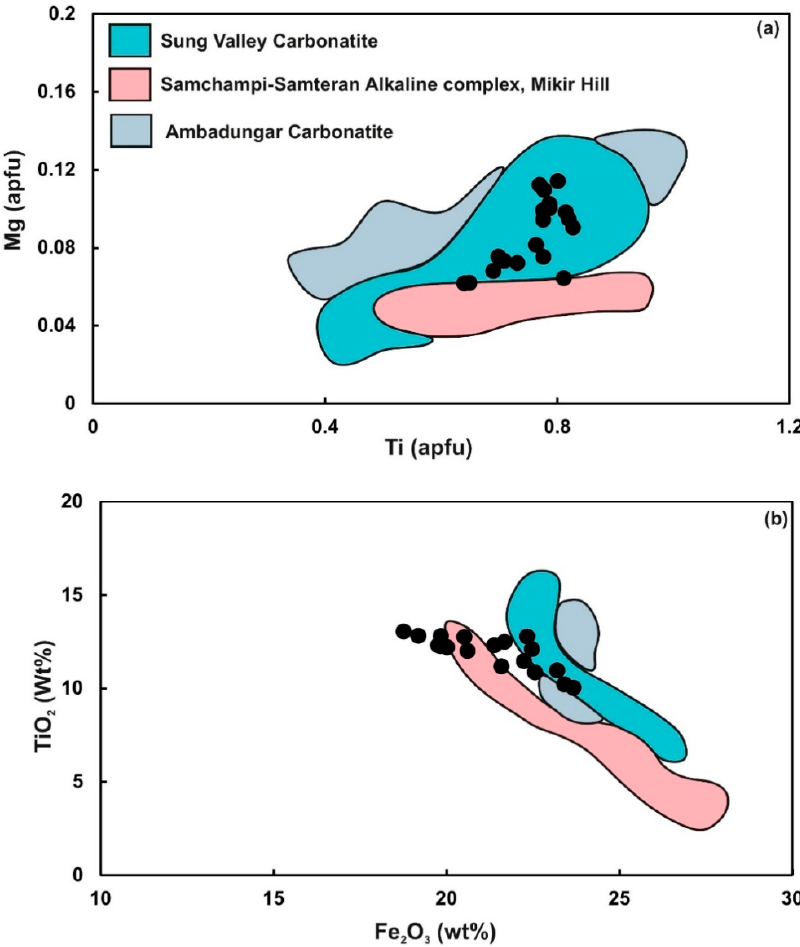
Figure 8. ( a ) TiO 2 versus Fe 2 O 3 , and ( b ) Mg (apfu) versus Ti (apfu) diagrams for the studied garnet. Compositional range of garnets from Sung Valley carbonatites [53], Samchampi-Samteran [73], Ambadungar [20] are also shown for comparison.